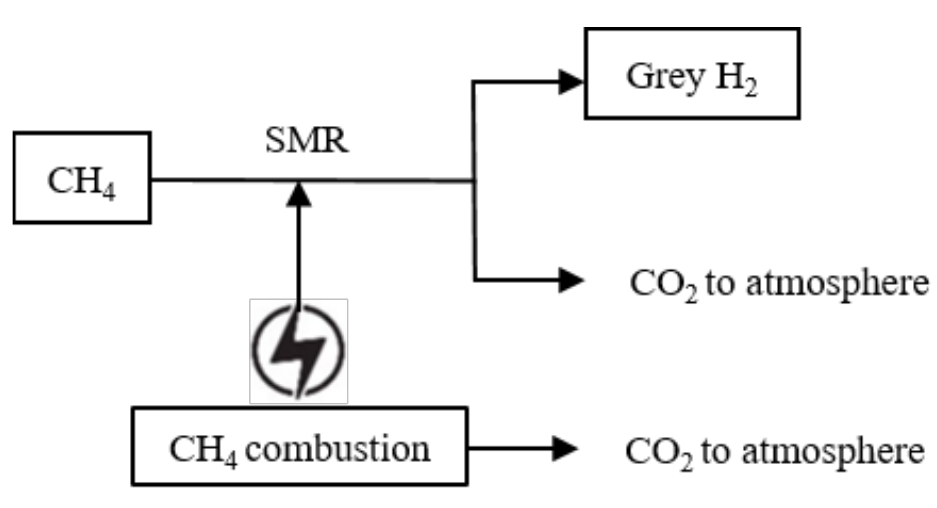
Figure 1. The PFD of grey hydrogen production.